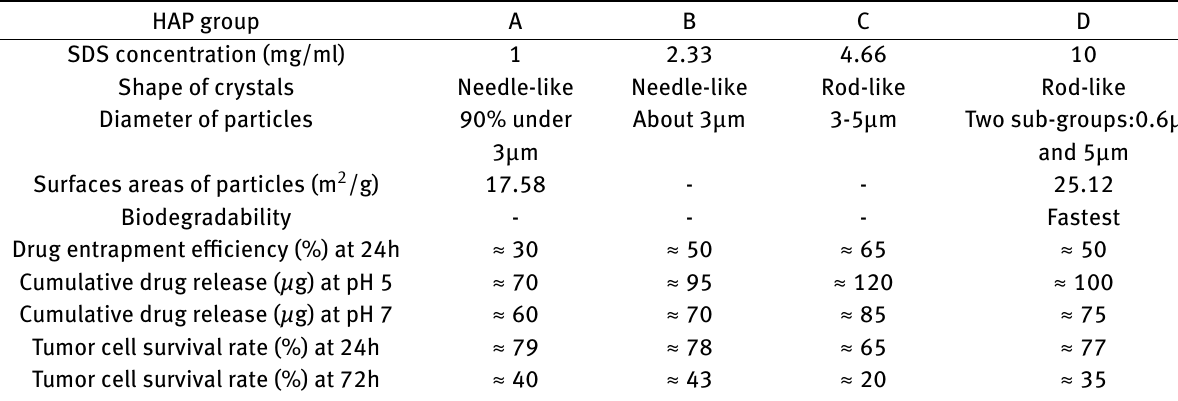
Table 3: Some experimental results of 4 HAP groups HAP group A B C D SDS concentration (mg/ml) 1 2.33 4.66 10 Shape of crystals Needle-like Needle-like Rod-like Rod-like Diameter of particles 90% under About 3 µ m 3-5 µ m Two sub-groups:0.6 µ m 3 µ m and 5 µ m Surfaces areas of particles (m 2 /g) 17.58 - - 25.12 Biodegradability - - - Fastest Drug entrapment eflciency (%) at 24h ≈ 30 ≈ 50 ≈ 65 ≈ 50 Cumulative drug release ( µ g) at pH 5 ≈ 70 ≈ 95 ≈ 120 ≈ 100 Cumulative drug release ( µ g) at pH 7 ≈ 60 ≈ 70 ≈ 85 ≈ 75 ≈ 79 ≈ 78 ≈ 65 ≈ 77 ≈ 40 ≈